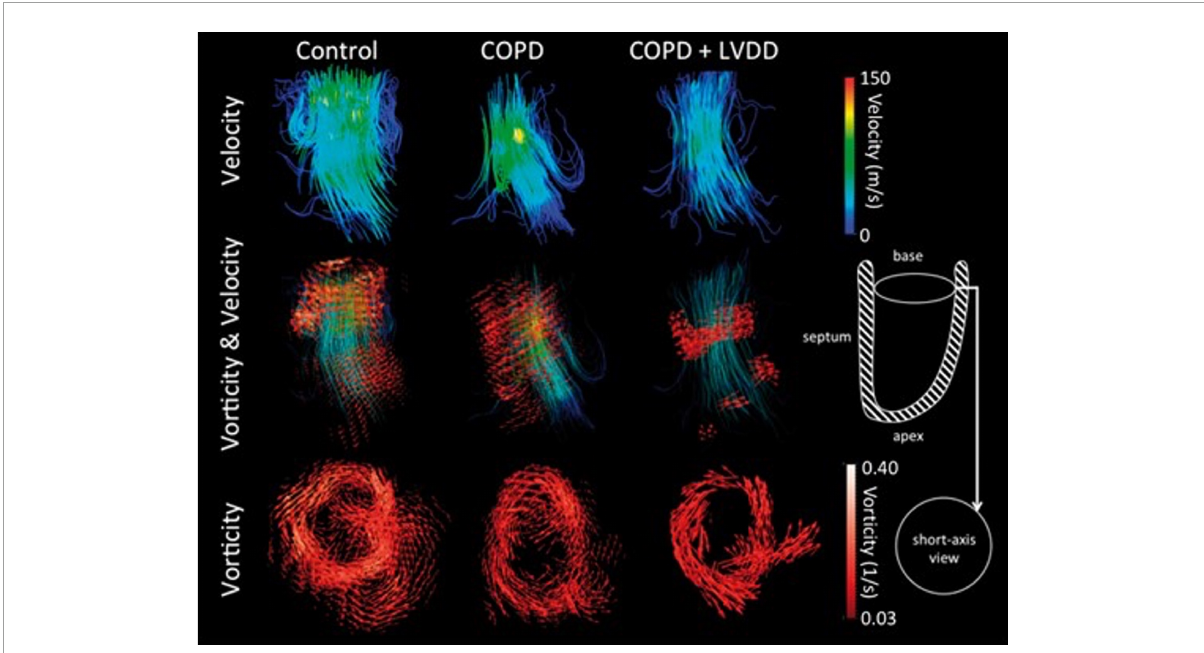
FIGURE6 Streamline visualization with velocity color coding of diastolic flow in controls, COPD patients with and without left ventricular diastolic dysfunction (LVDD) (Top row) . Streamline visualization of diastolic flow with superimposed vorticity vector fields (Middle row) . Vorticity vector fields in all three groups, showing a loss of vorticity in both COPD with and without LVDD (Bottom row) (68).